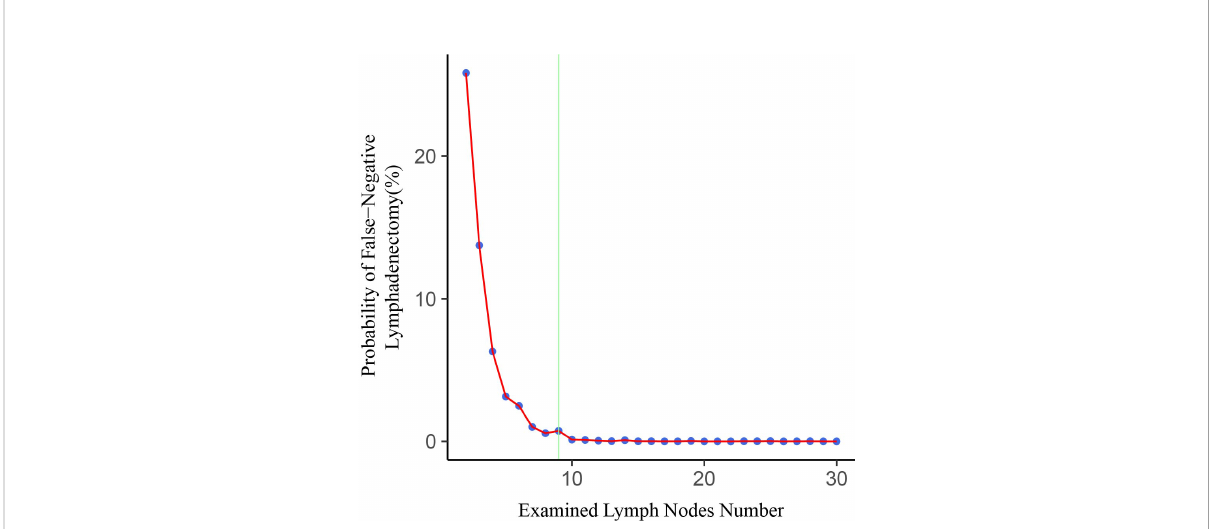
FIGURE 3 Association of examined lymph node (ELN) number with probability of undetected positive lymph nodes in a patient with truly LN-positive disease. The structural breakpoint determined by using ‘ strucchange ’ packages in R is shown in green.